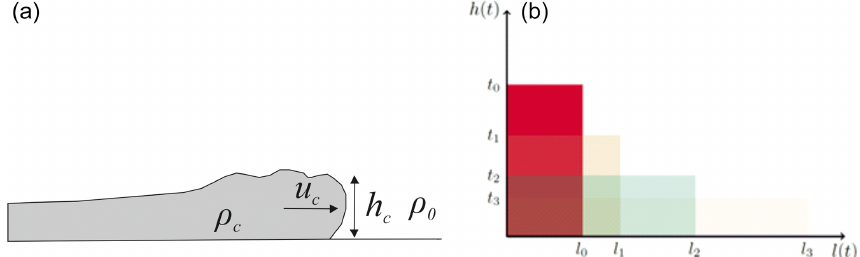
Figure 1. (a) Schematic diagram of an inertial gravity current with a depth h c , flow front velocity u c and density ρ c in an ambient fluid of density ρ 0 (modified from Roche et al., 2013); (b) evolution of channelized currents through a series of equal-area rectangles, according to the model (hence the name “box